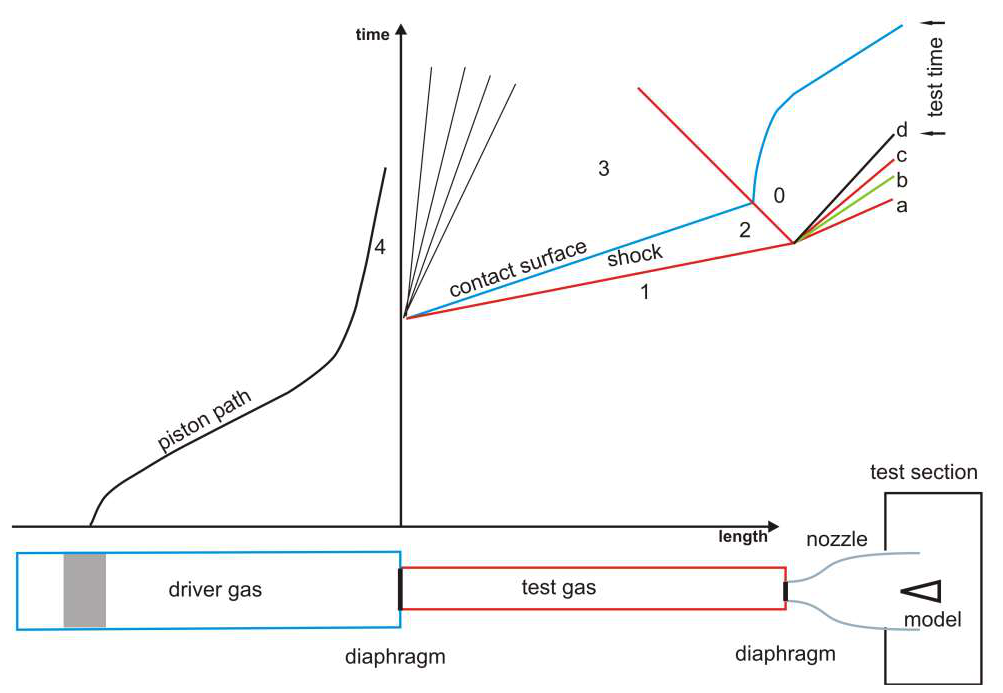
Figure 1: Schematic of a free piston driven shock tunnel and the wave (x-t)